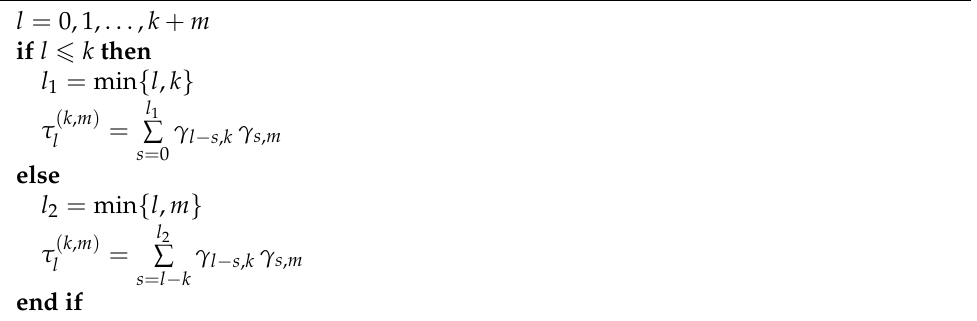
Algorithm 2 The computation of the coefficient τ